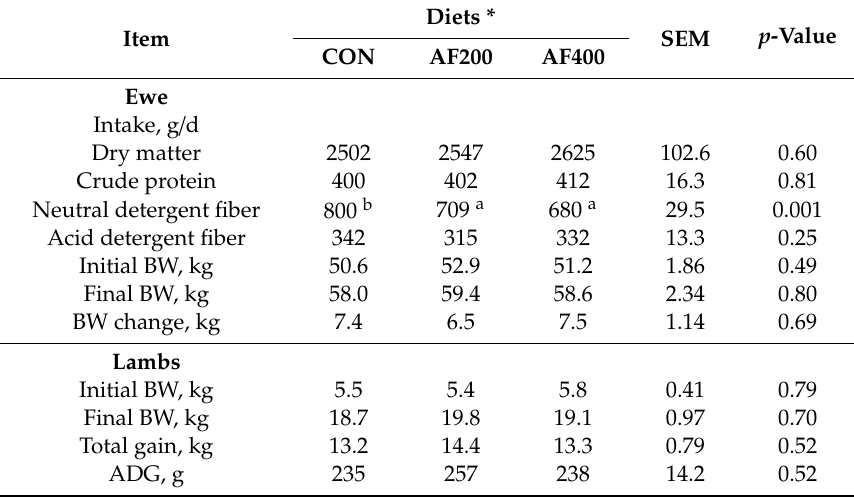
Table 3. Intake and BW change in lactating Awassi ewes fed diets containing alternative feeds (AF). Item